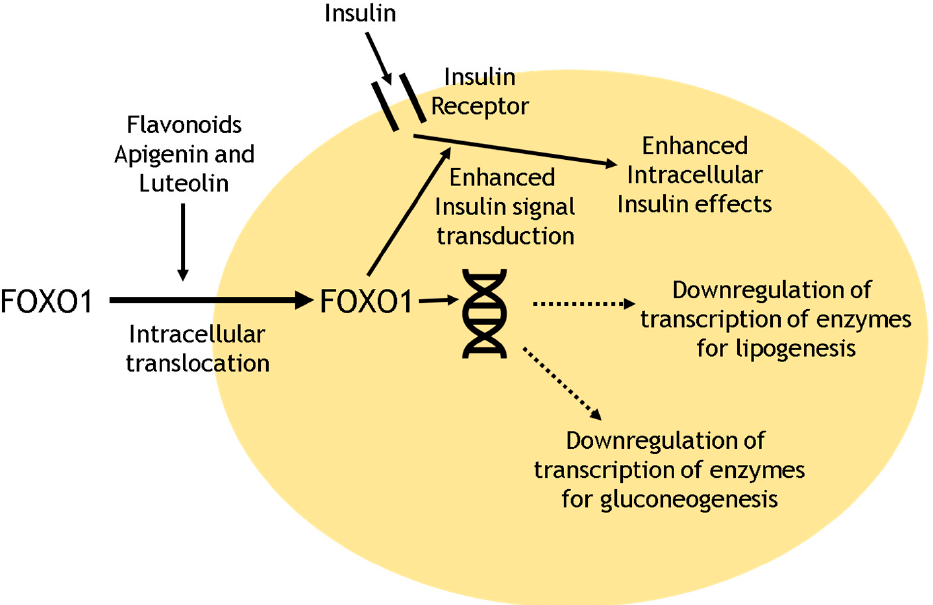
Figure 2. Schematic outline of flavonoid effects on cellular metabolism. FOXO1: Forkhead box transcription factor 01.